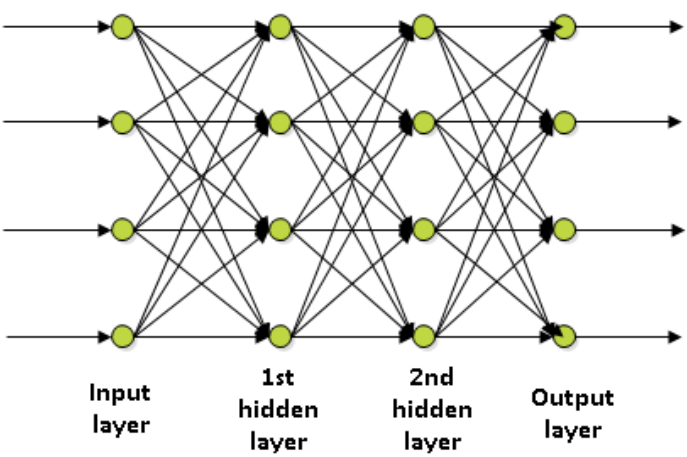
Figure 1. A Feed-Forward Neural Network (FFNN) with 4 inputs, 4 outputs, and 2 hidden layers.